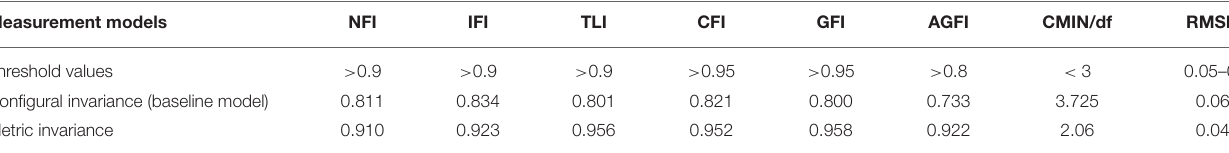
TABLE 3 | The analysis of model